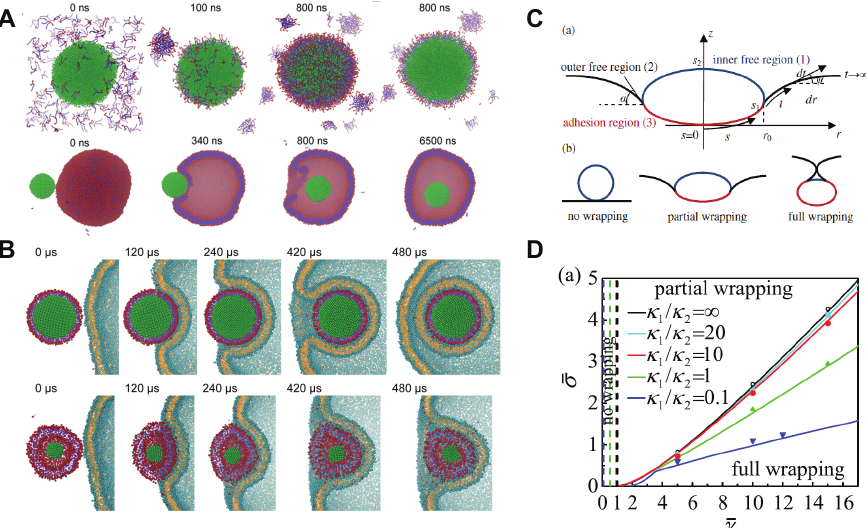
Figure 6. Self-assembly and subsequent endocytosis of lipid molecule-decorated NPs (MPs and BPs). ( A ) Computational modeling on the self-assembly process of the modes A and B given in Figure 3A. In mode A ( Upper part), the NP core could interact with the random lipids and form the MPs. While in mode B ( Lower Part), the NP core will interact with the pre-assembled liposome and form the BPs; ( B ) Snapshots of the MPs and BPs interacting with a vesicle. Upper and lower parts are corresponding to the MPs and BPs, respectively; ( C ) Schematic of different states of the endocytosis of soft NP; ( D ) Phase diagram for the endocytosis of NPs with different stiffness. κ 1 and κ 2 are the bending rigidities of the NP and membrane, respectively. The solid lines represent the phase boundaries between the fully wrapping and partial wrapping regimes. The horizontal axis represents the adhesion energy ¯ γ and the vertical one denotes the membrane tension ¯ σ . These figures are adapted from References [51,64] with